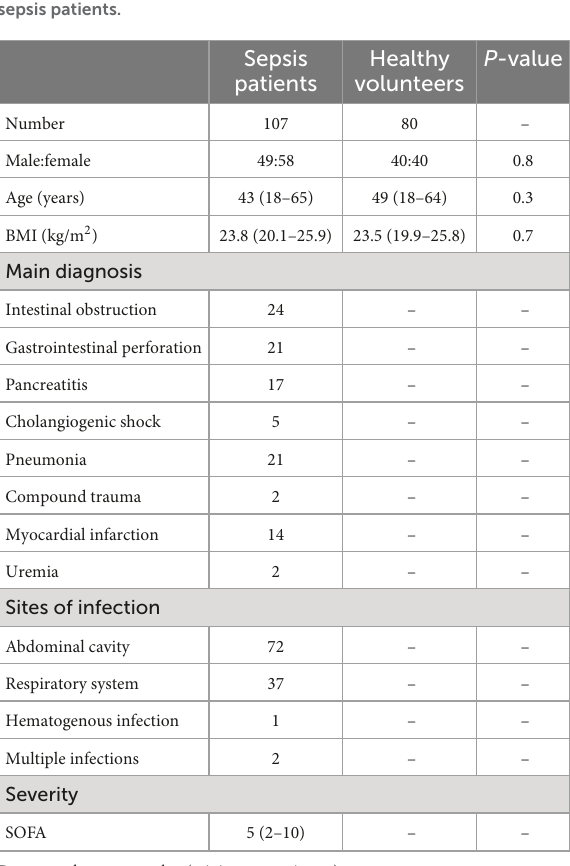
TABLE 2 Demographic characteristics of healthy volunteers and sepsis patients.